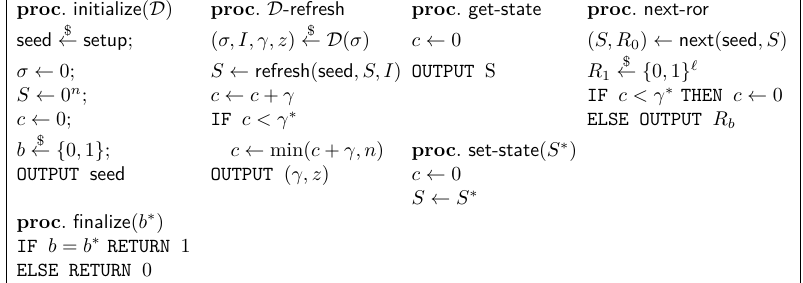
Figure 18: Procedures in Security Game ROB ( γ ∗